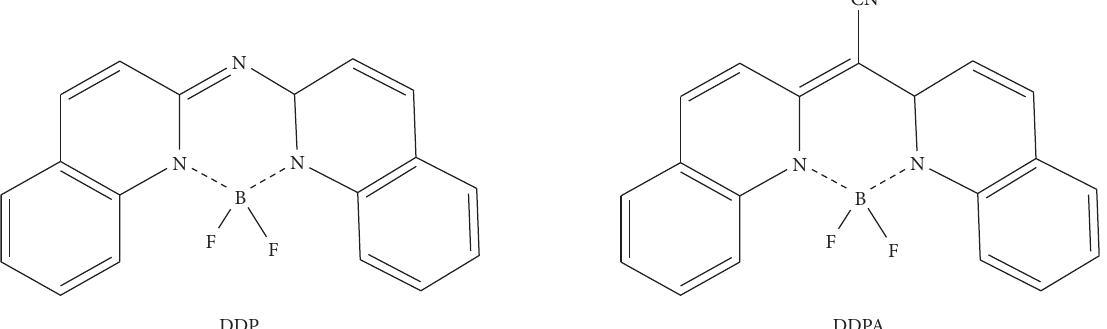
Figure 8: The molecular structures of DDP and